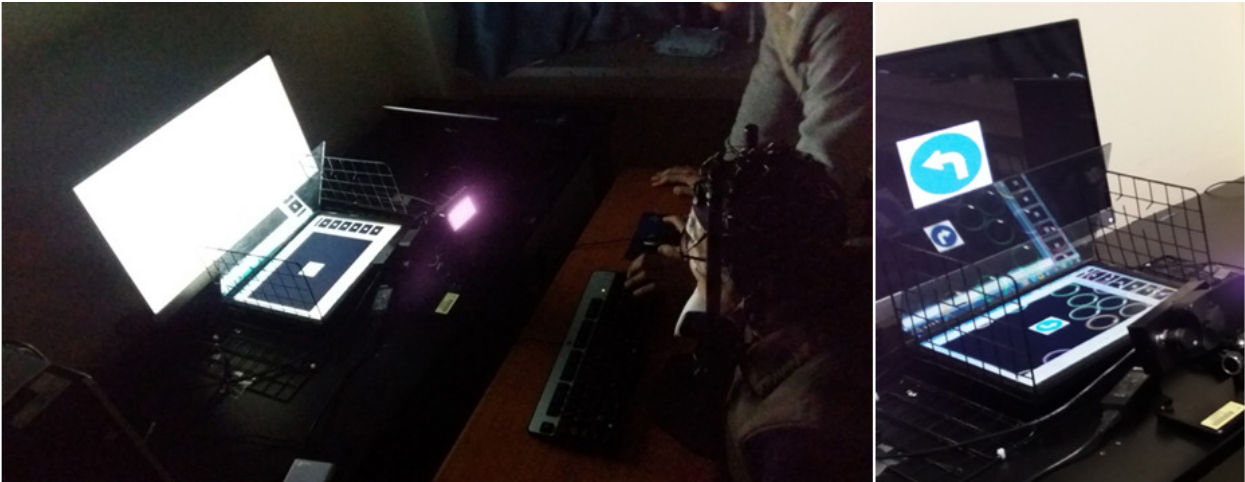
Figure 2. HUD display device constructed in the laboratory: Instead of the HUD device in the vehicle, a reflector was made with a simple fixing device with a glass plate, and the position of the face was adjusted and fixed for each individual so that two traffic signals could be clearly